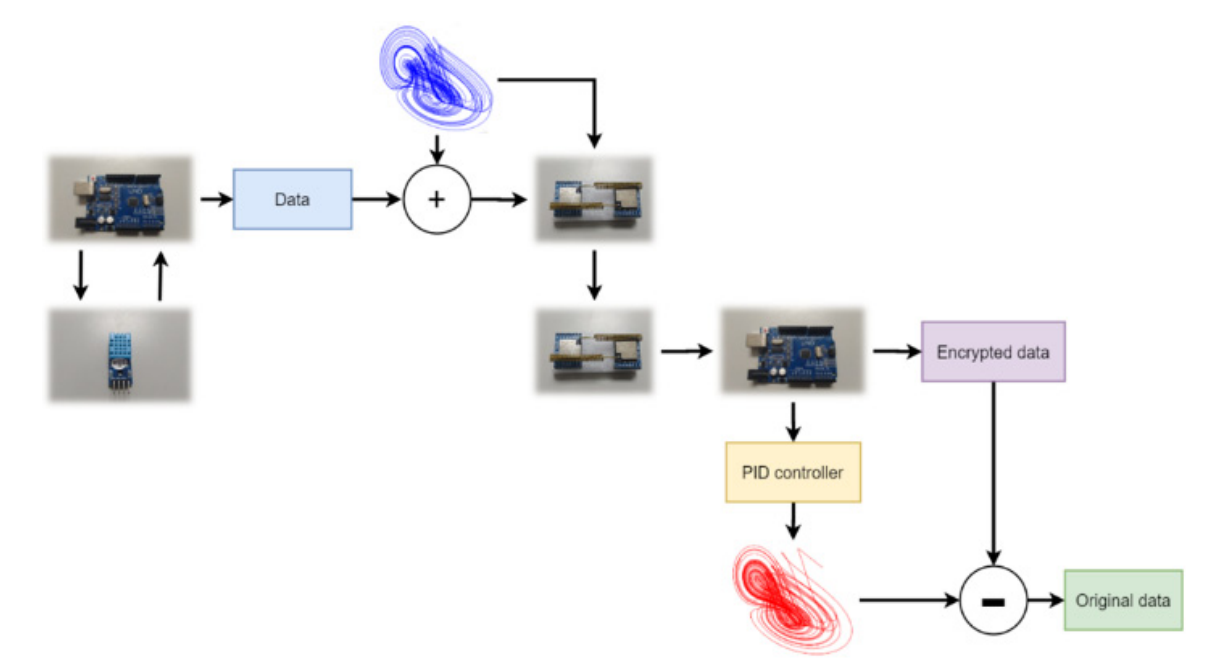
Figure 17. Chaotic system encryption IoT signal architecture diagram.